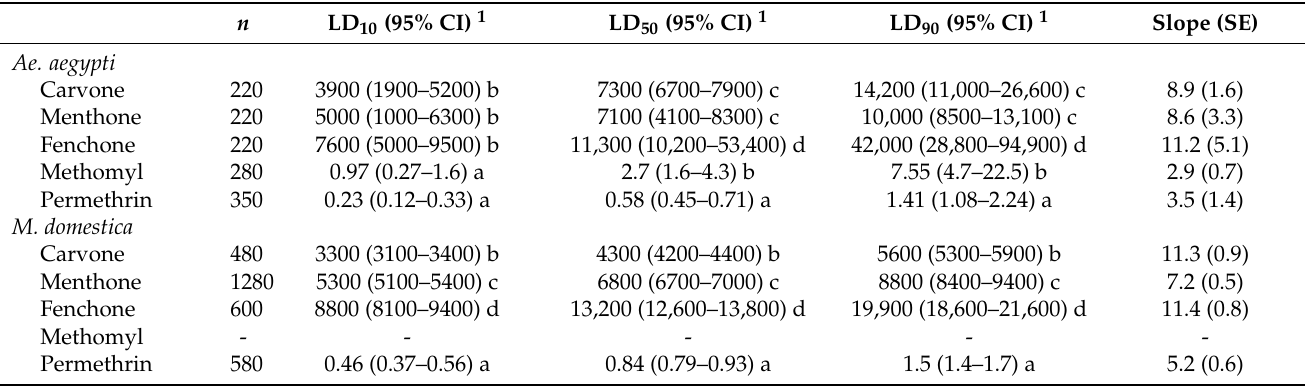
Table 1. Twenty-four-hour lethal doses of topically applied monoterpenoids, methomyl, and perme- thrin in adult females with susceptible strains of Aedes aegypti and Musca domestica